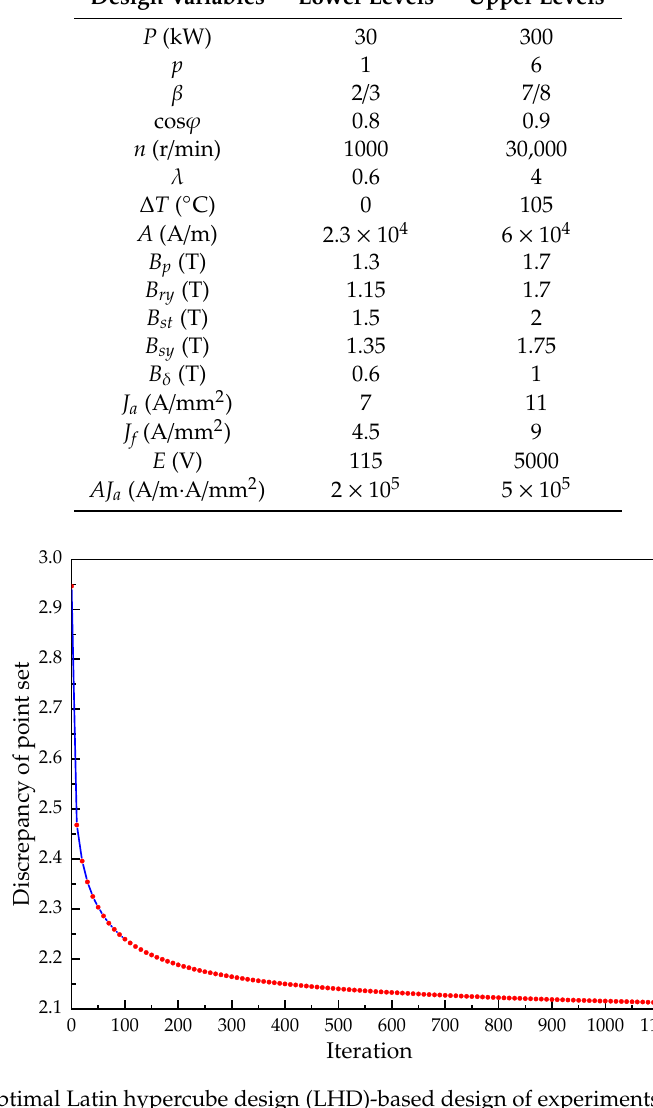
Figure 6. Optimal Latin hypercube design (LHD)-based design of experiments (DOE) process.